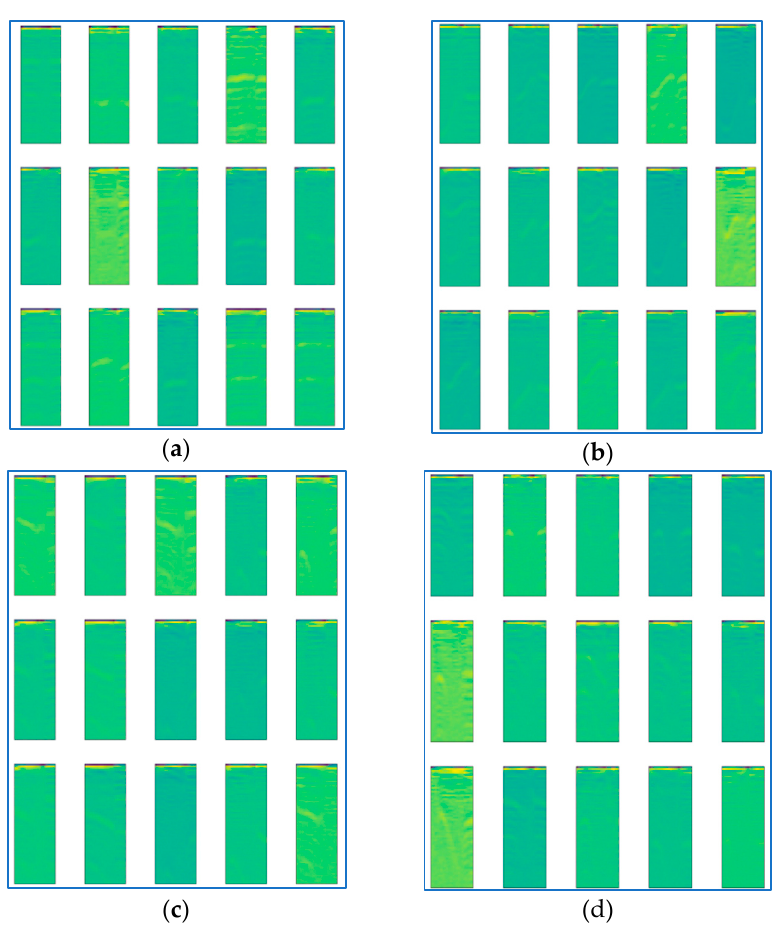
Figure 5. Training data for the pronunciation task designed in this study. ( a ) Combination of tone 1 and tone 1; ( b ) Combination of tone 2 and tone 1; ( c ) Combination of tone 3 and tone 1; ( d ) Combination of tone 4 and tone 1.